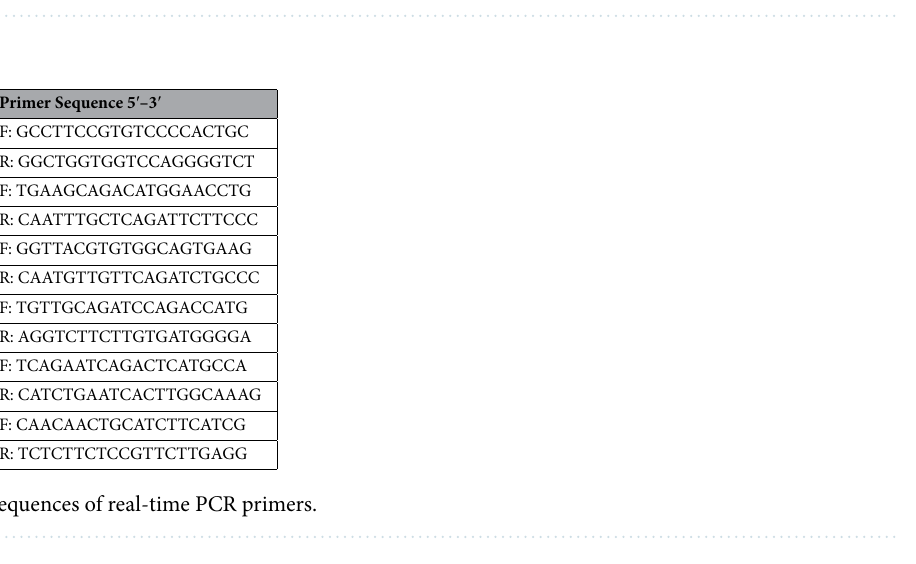
Table 1. Characteristics of patients with lacrimal gland benign lymphoepithelial lesion and orbital cavernous hemangioma. *Fisher’s exact probability method. # Wilcoxon-Mann–Whitney U two sample test.